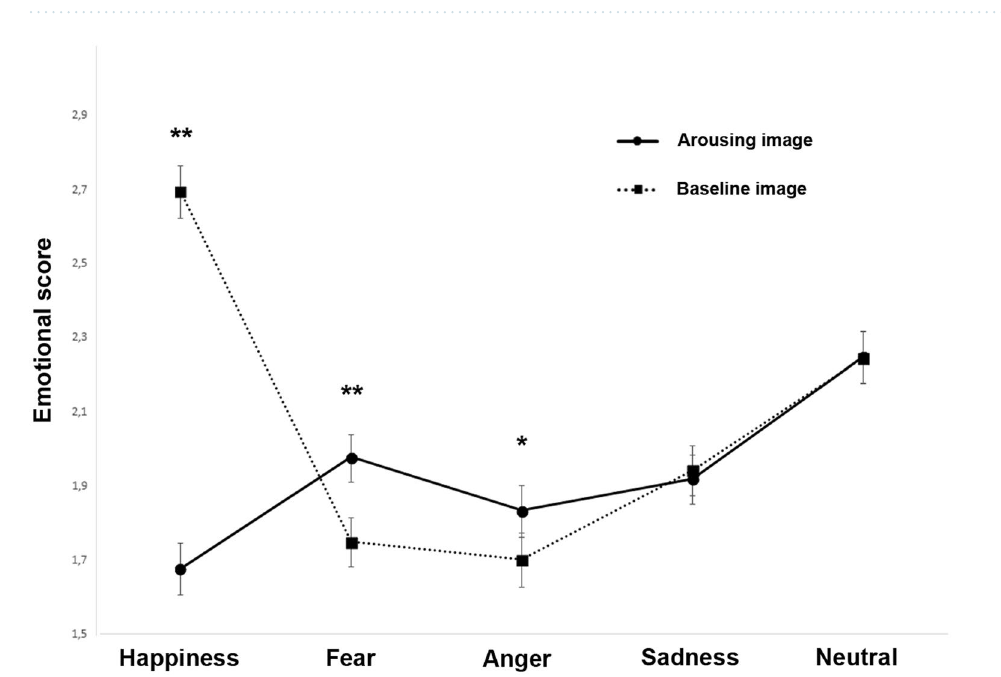
Figure 6. Emotional score (1). Dog facial expressions rated by humans for each emotional category (i.e. happiness, fear, anger, sadness, and neutral) during the baseline and arousing experimental conditions (group means with SEM are shown; Asterisks indicate significant biases. * P < 0.05; ** P < 0.001; Fisher’s LSD